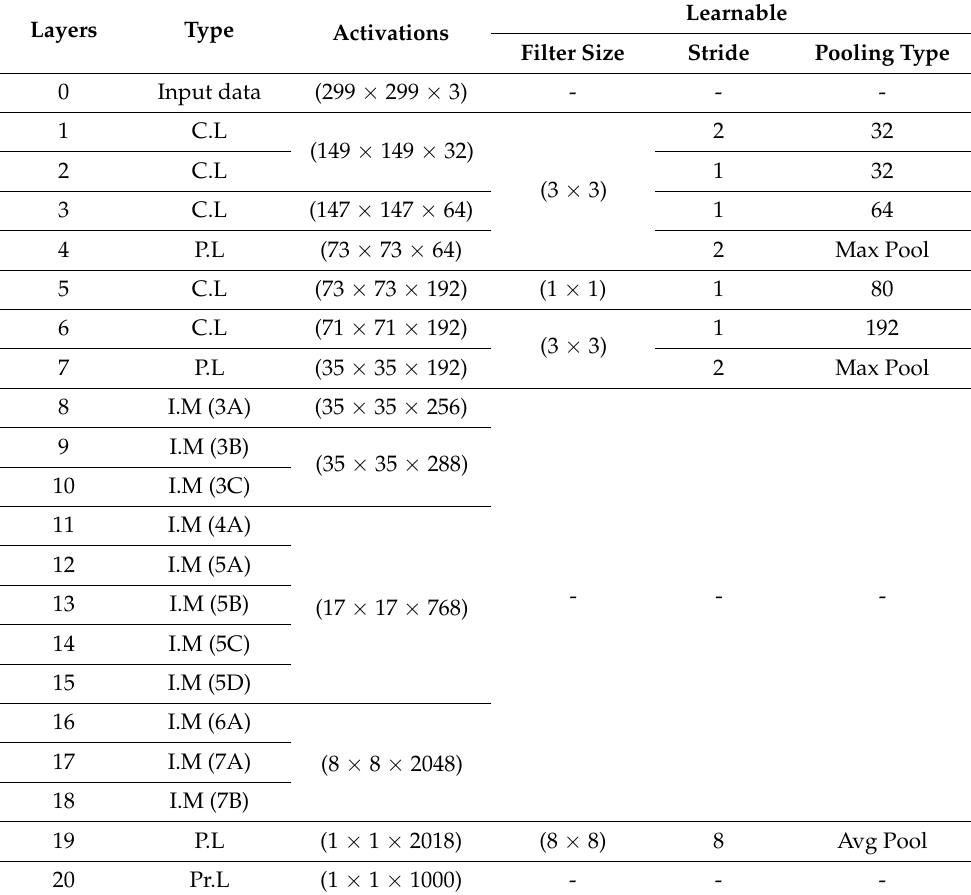
Table 2. The Inception-V3 network’s architecture is broken down into its constituent layers: the convolutional layer (C.V), the pooling layer (P.L), the inception module (I.M), and the predictions layer (Pr. L). Learnable Layers Type Activations Filter Size Stride Pooling Type 0 Input data (299 × 299 × 3)